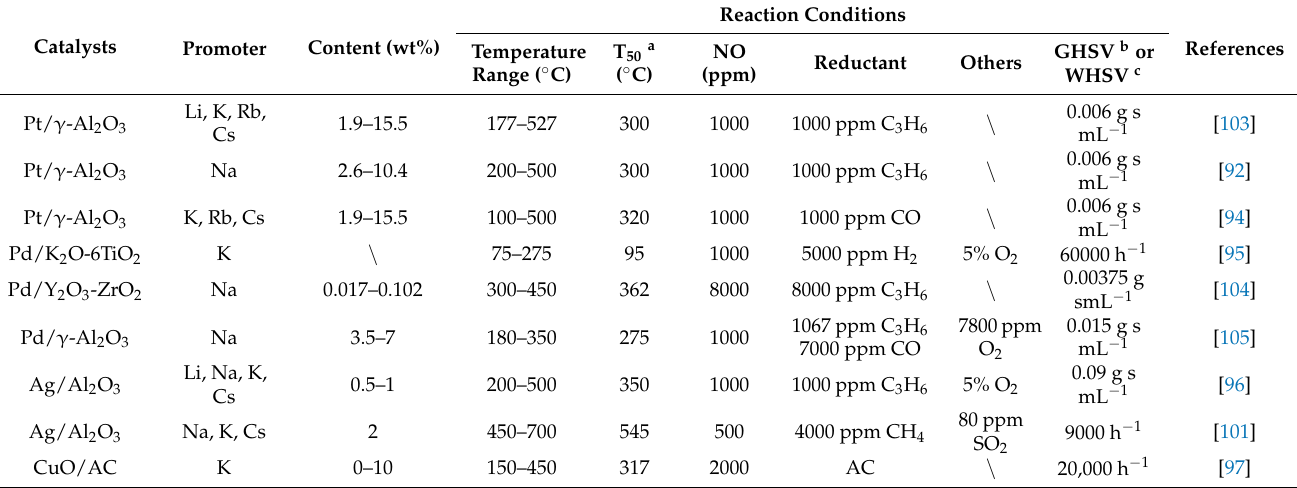
Table 4. Summary of catalysts and reaction conditions for NO reduction promoted by alkali